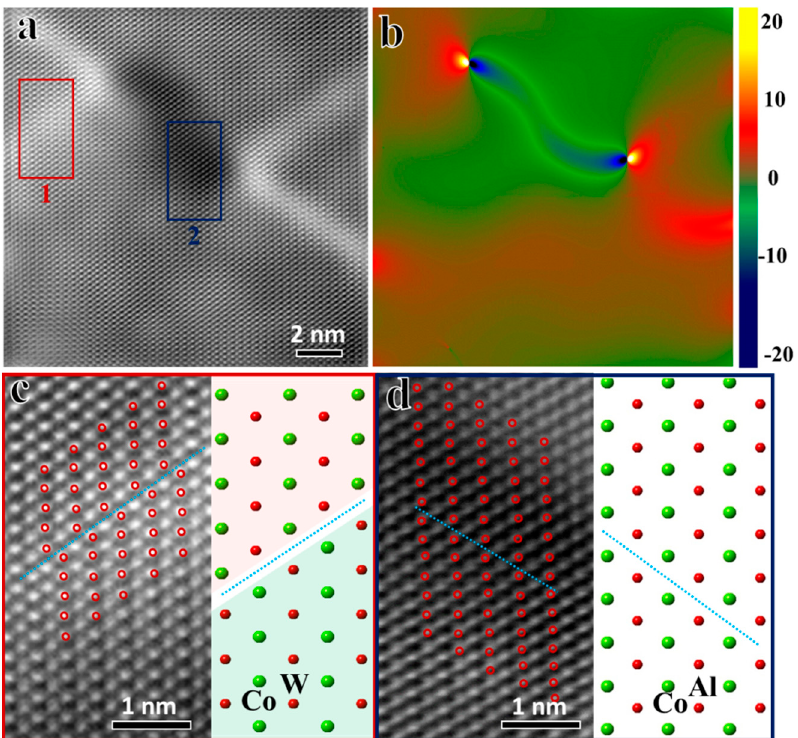
− 1 / 2 plane (2 a) shift along the SF line. Part of the APB indexed in square 2 is enlarge and analysed in Figure 4d. Bright contrast dots which represent the W(Al) rich rows were plot out by red circles and yellow dashed lines circled out boundaries of the APB, and it indicates that there was no atomic plane Crystals 2020 , 10 , x FOR PEER REVIEW shift across the APB.